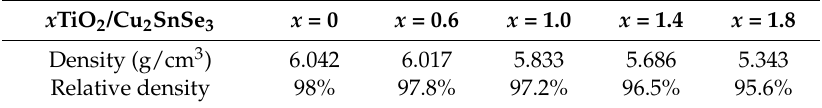
Table 1. Density of the x vol % TiO 2 /Cu 2 SnSe 3 composites with different nano-TiO 2